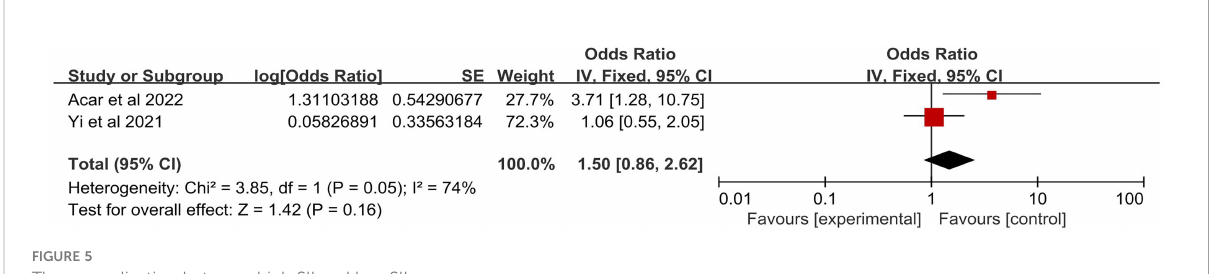
FIGURE 5 The recanalization between high SII and low SII